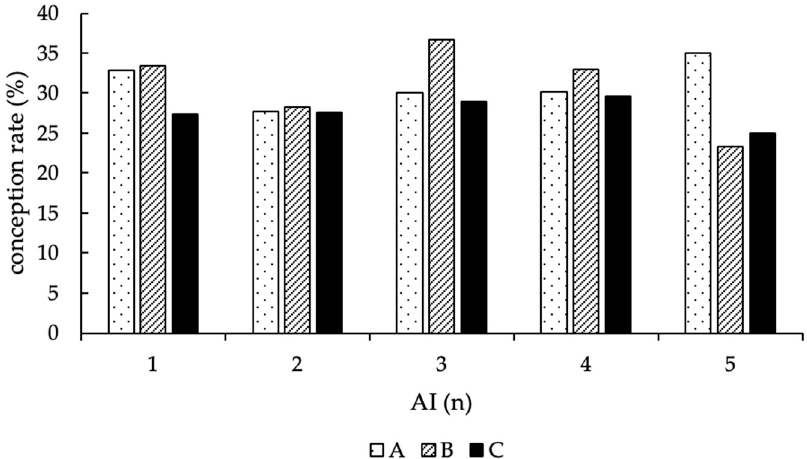
Figure 5. Distribution of the conception rates (in %) according to the number of AI and thawing methods (A = 11 s, 38 ◦ C water bath; B = 35 s, 38 ◦ C water bath; C = 30 s, “in the cow”). methods (A = 11 s, 38 °C water bath; B = 35 s, 38 °C water bath; C = 30 s, “in the cow”).